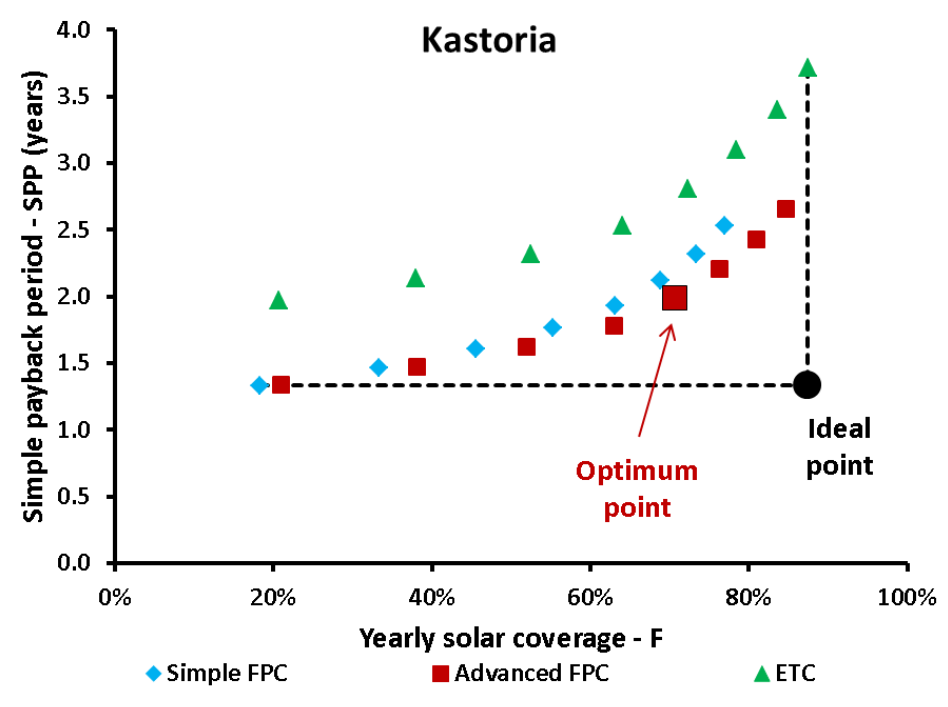
Figure 31. Multi-objective optimization for the Kastoria city—Zone D. Table 8. Final summary of the optimum designs according to the multi-objective